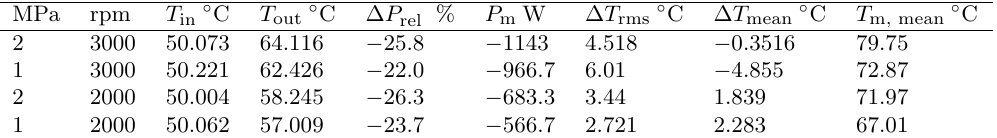
. The power loss 2 67 . 01